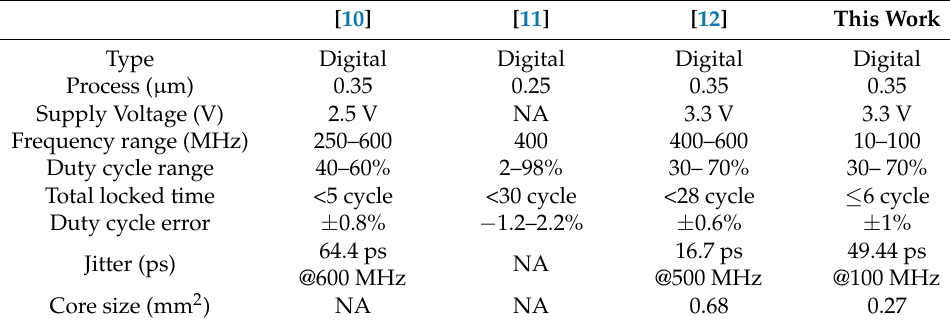
Table 1. Comparison with previous